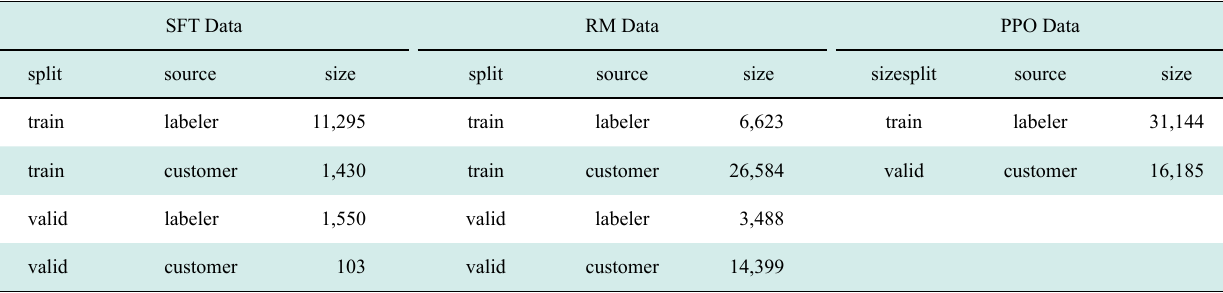
Figure 8 The volume and distribution of the data were trained by InstructGPT. InstructGPT useed a small amount of labeled data by human for training, but it shows a high robustness that aligns with human values, making this method more feasible for medical scenarios with less labor cost [2].